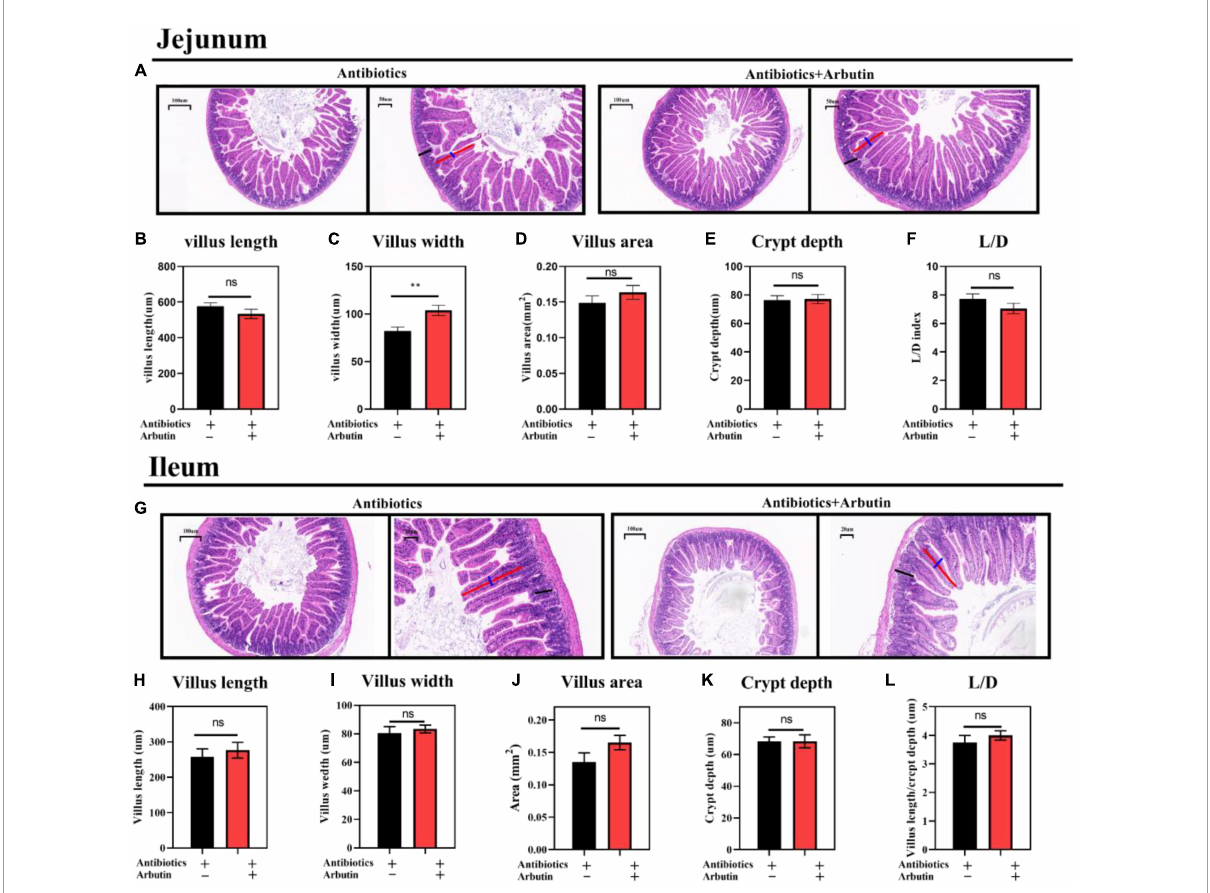
FIGURE5 Arbutin administration improved jejunal and ileal gut development after oral cocktails. HE staining of the jejunum (A) , villus length in the jejunum (B) , villus width in the jejunum (C) , villus areas in the jejunum (D) , crypt depth in the jejunum (E) , L/D in the jejunum (F) , HE staining of